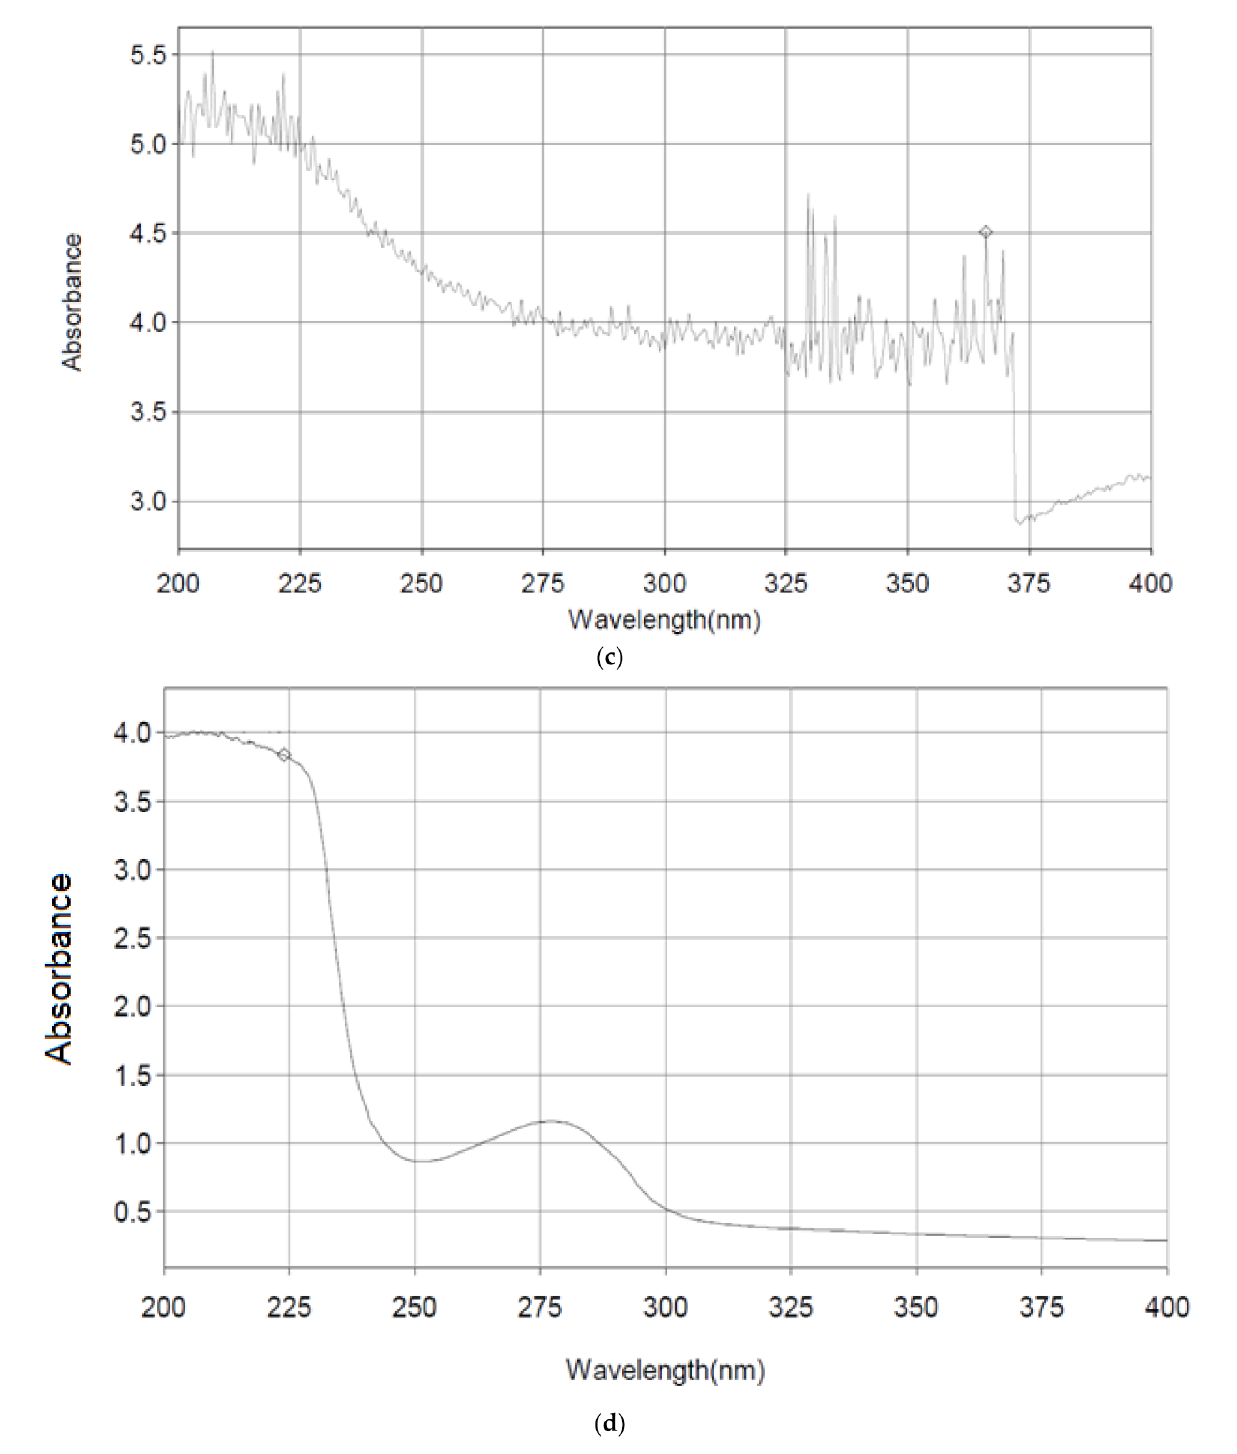
Figure 8. ( a ) Detection of PEE. UV Spectrum Starts at 200 nm and ends at 900 nm with absorbance starts at 5.046 nm and ends at 0.2252 nm. ( b ) Detection of CV. UV Spectrum Starts at 200 nm and ends at 900 nm with absorbance starts at 4.523 nm and ends at 0.401 nm. ( c ) Detection of CV-PEE mix UV Spectrum Starts at 200 nm and ends at 400 nm with absorbance starts at 5.222 nm and ends at 0.2252 nm. ( d ) Detection of IRRV. UV Spectrum Starts at 200 nm and ends at 400 nm with absorbance starts at 3.979 nm and ends at 0.291